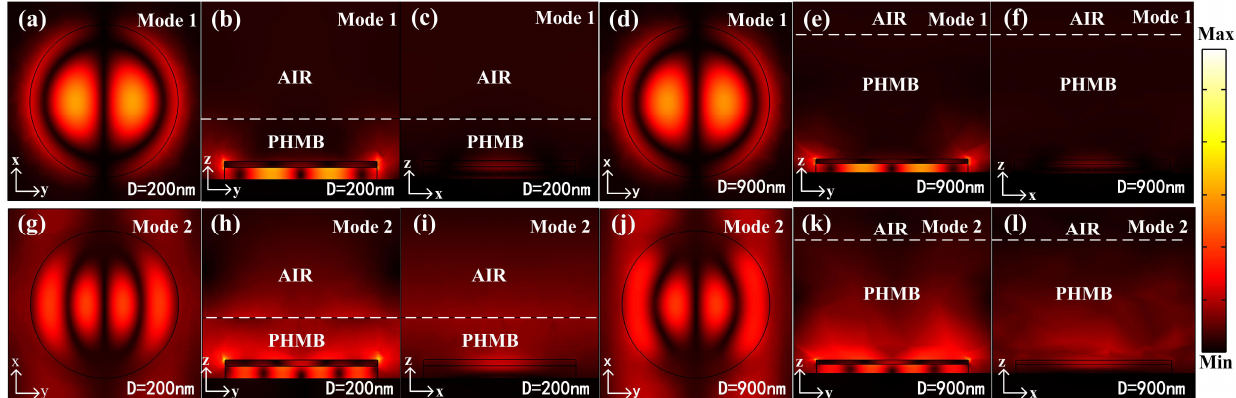
Figure 6. The normalized electric field profiles corresponding to the two resonant modes when the PMHB thickness is 200 nm and 900 nm. ( a – f ) represent the electric field distributions of mode 1 for D = 200 nm in x-y ( a ), y-z ( b ) and z-x ( c ) plane, and D = 900 nm in x-y ( d ), y-z ( e ) and z-x ( f ) plane. ( g – l ) represent the electric field distributions of mode 2 for D = 200 nm in x-y ( g ), y-z ( h ) and z-x ( i ) plane, and D = 900 nm in x-y ( j ), y-z ( k ) and z-x ( l ) plane. The white dashed lines show the interface